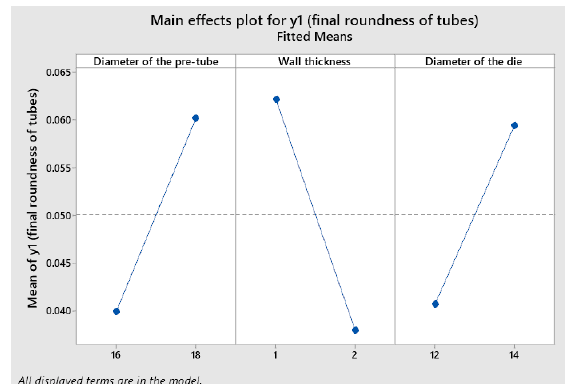
Figure 8. Main effects plot for the variable y1, or the final roundness of the tube.